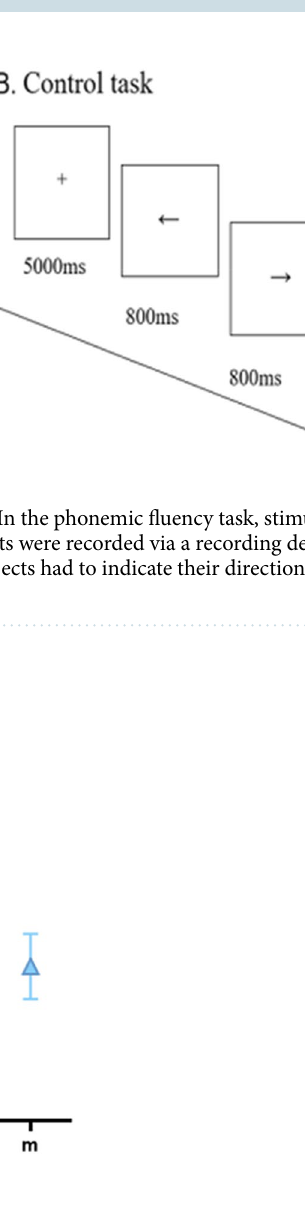
Figure 3. Phonemic fluency material results. The mean number of words for each consonant in the pilot